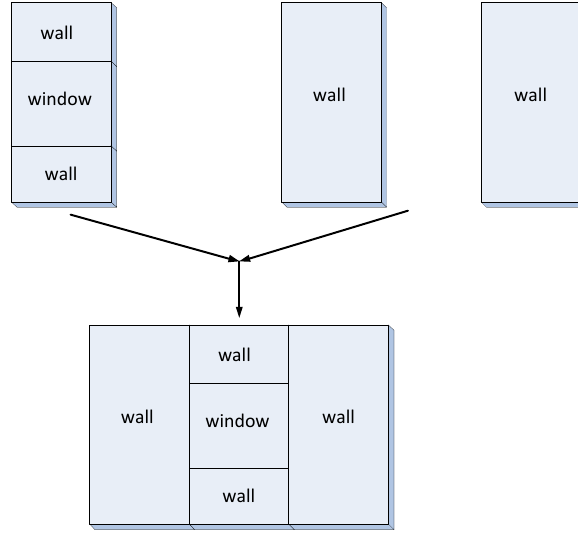
Figure 5: The construction of a window with its adjacent wall parts.